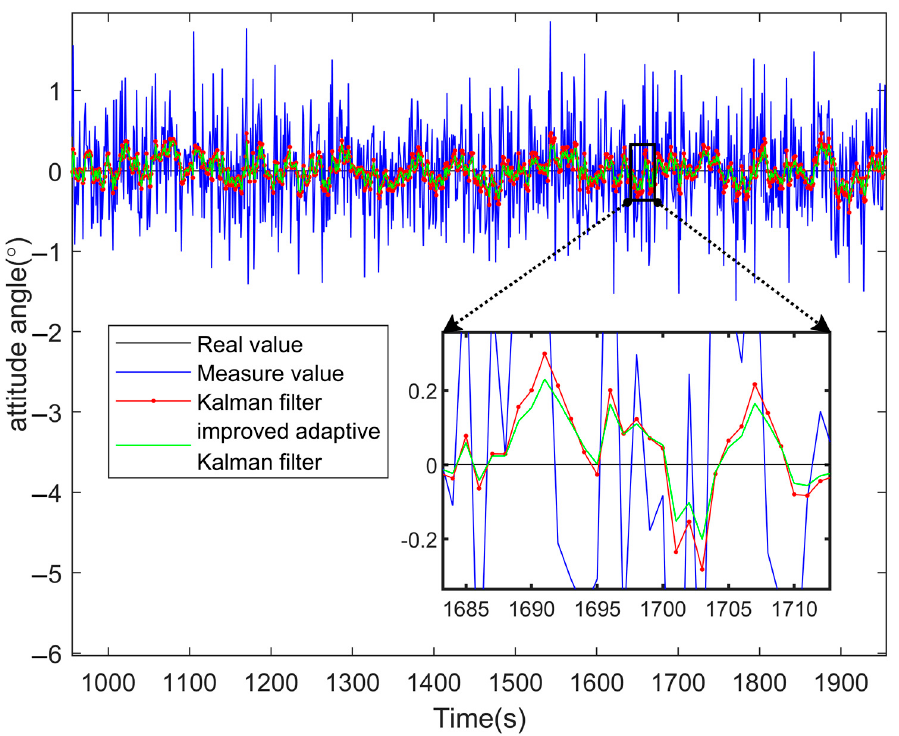
Figure 11. Simulation of IAKF sowing monomer attitude angle.